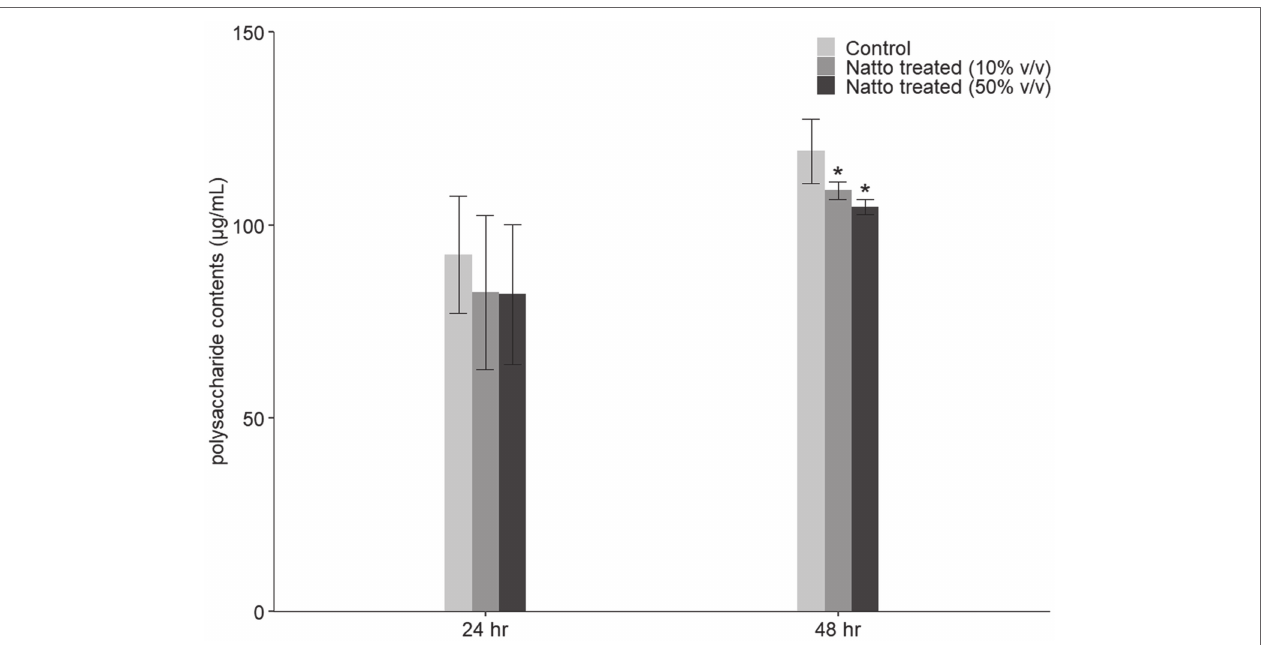
FIGURE 5 | Inhibitory effect of B. subtilis natto supernatant on E. faecalis biofilm polysaccharide production. E. faecalis OG1RF was anaerobically cultured in M9B broth without or with B. subtilis natto supernatant (0, 10, and 50% v/v) for 24 or 48 h. The polysaccharide contents obtained from E. faecalis biofilms were determined using the PSA method. The data are presented as the means ± SDs ( n = 3). Values with asterisks (*) were significantly different compared with each negative control group according to Duncan’s multiple range tests (* p < 0.05).